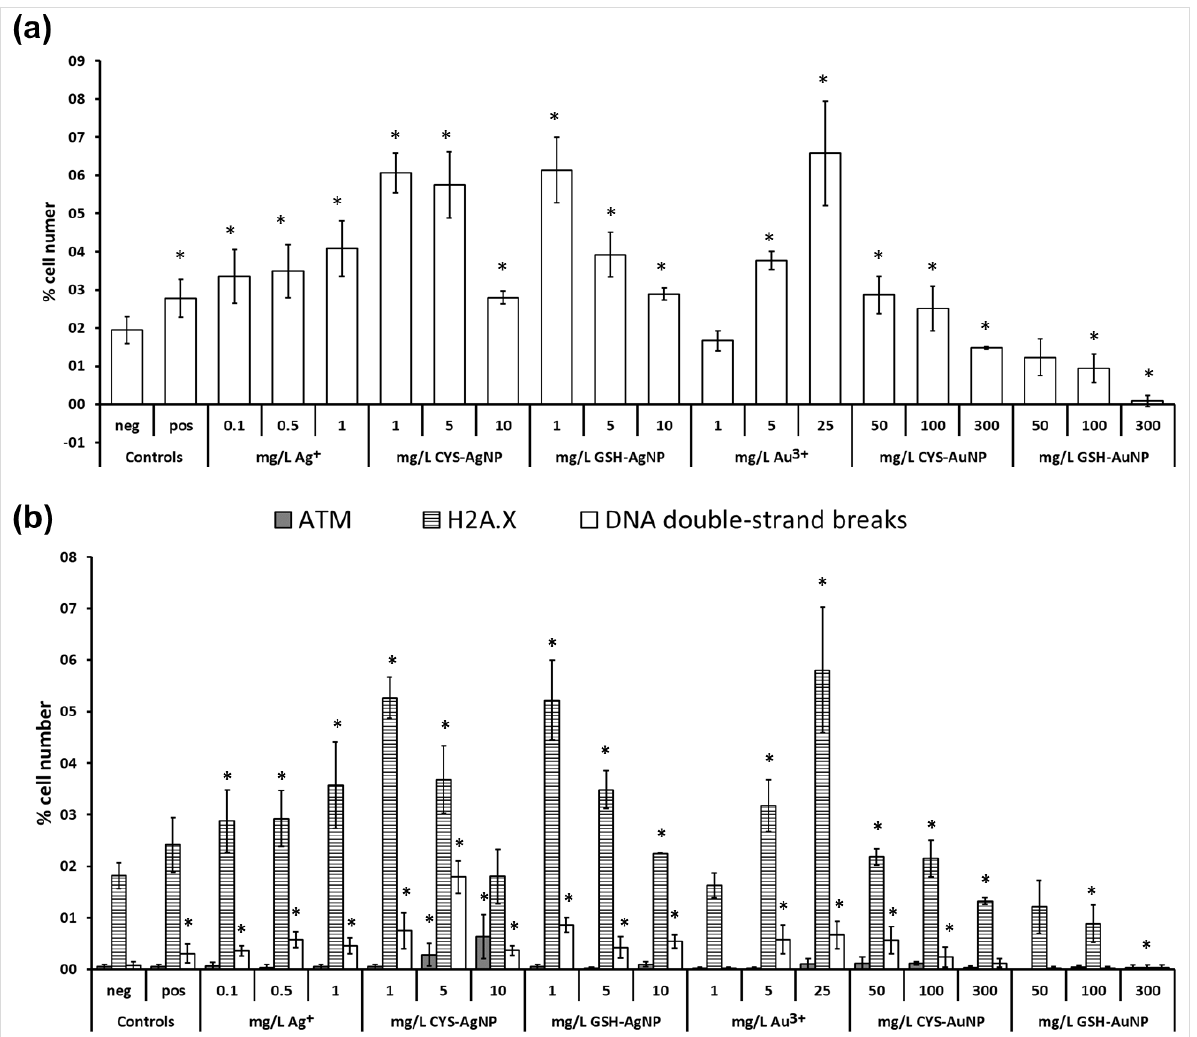
Figure 6: The effect of silver (AgNPs) and gold nanoparticles (AuNPs) stabilized with cysteine (CYS) or glutathione (GSH), Ag + and Au 3+ ions on (a) total DNA damage and (b) DNA double-stranded breaks (white columns), the activation of ATM (grey columns) and H2A.X (striped columns) in L929 cells after 24 h exposure, measured with Muse TM Multi-Color DNA Damage Kit. Negative controls (Neg) were untreated cells, while positive controls (pos) were cells treated with DMSO. The results are expressed as the percentage of negative controls and given as mean values obtained from three independent experiments. Standard deviations are presented as scale bars. The values marked with an asterisk (*) differ significantly from the negative control ( P <